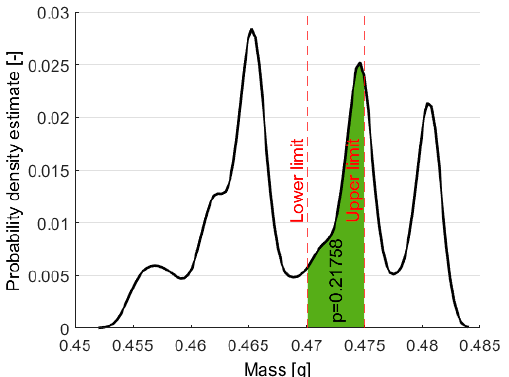
Figure 4. The probability density function of masses calculated with the kernel function (and the p -value, which shows the probability of random sampling from this class).